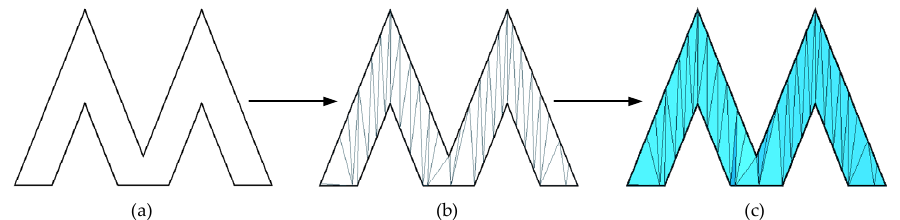
Figure 6. Schematic diagram of polygon triangulation: ( a ) the original polygon; ( b , c ) the process and the result of polygon triangulation.